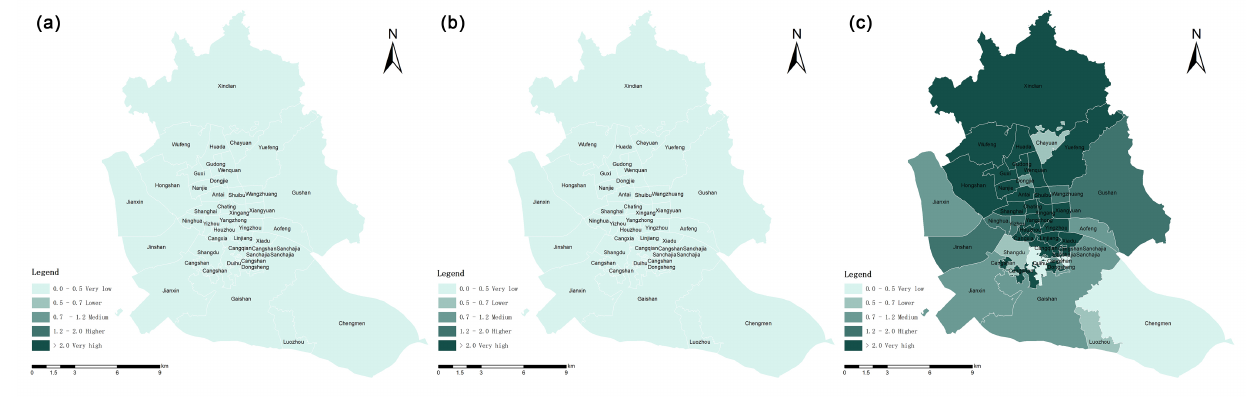
Figure 9. Locational entropy at sub-district scale under different traveling scopes ( a ) 5-min life circle. ( b ) 15-min life circle. ( c ) 30-min life